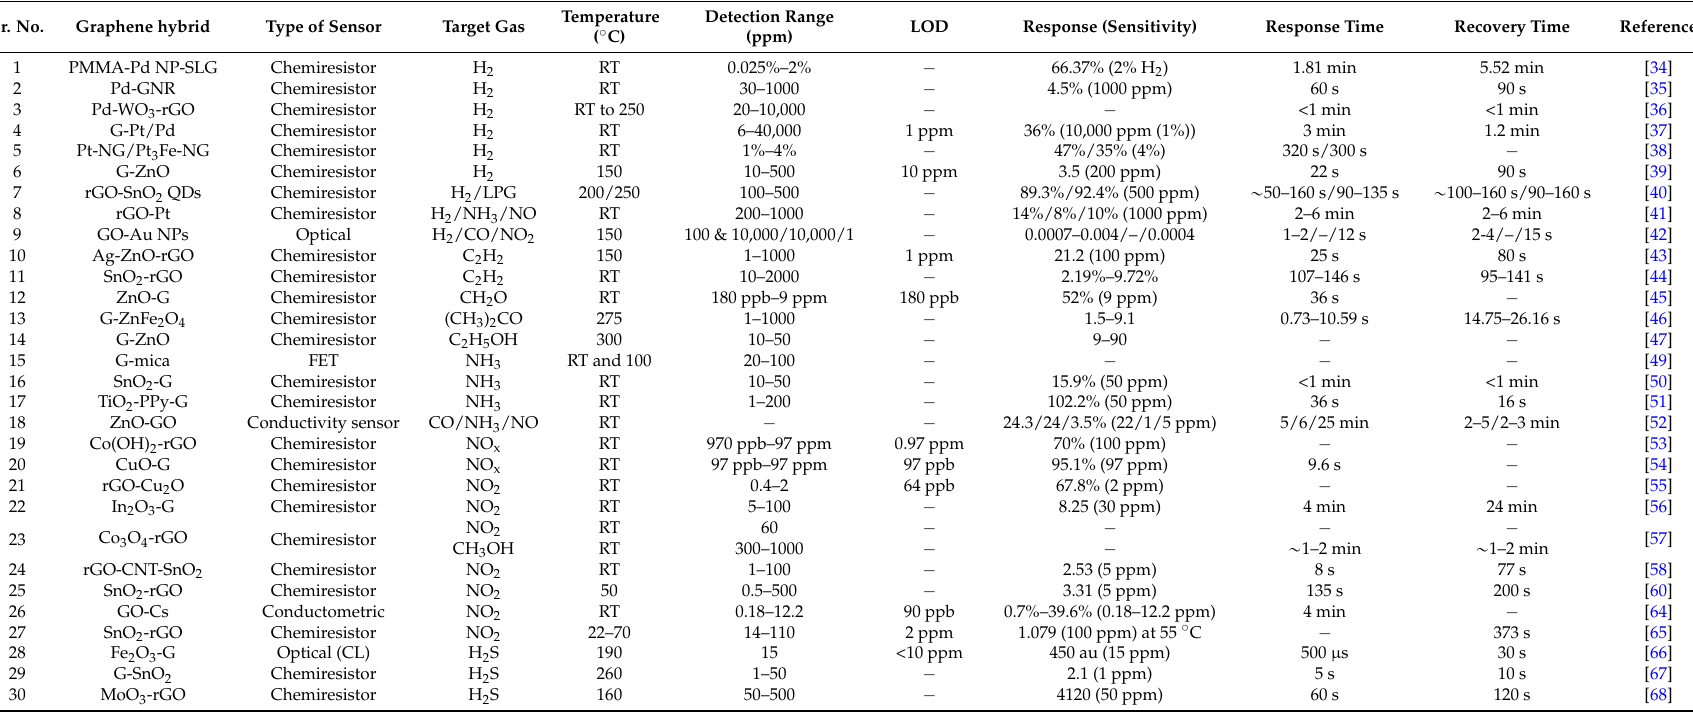
Table 3. Gas sensors based on graphene metal/metal oxide hybrids. G = Graphene; rGO = reduced grapheme; eG = epitaxial grapheme; SLG = single-layer grapheme; GNR = graphene nanoribbons, RT = room temperature, Pt = Platinum, Pd = Palladium, Au = Gold, NPs = nanoparticles, NG = nitrogen doped graphene, PPy = polypyrrole, P3HT = poly(3-hexylthiophene), NW = nanowires, Cs = caesium, QDs = quantum dots. Sr.